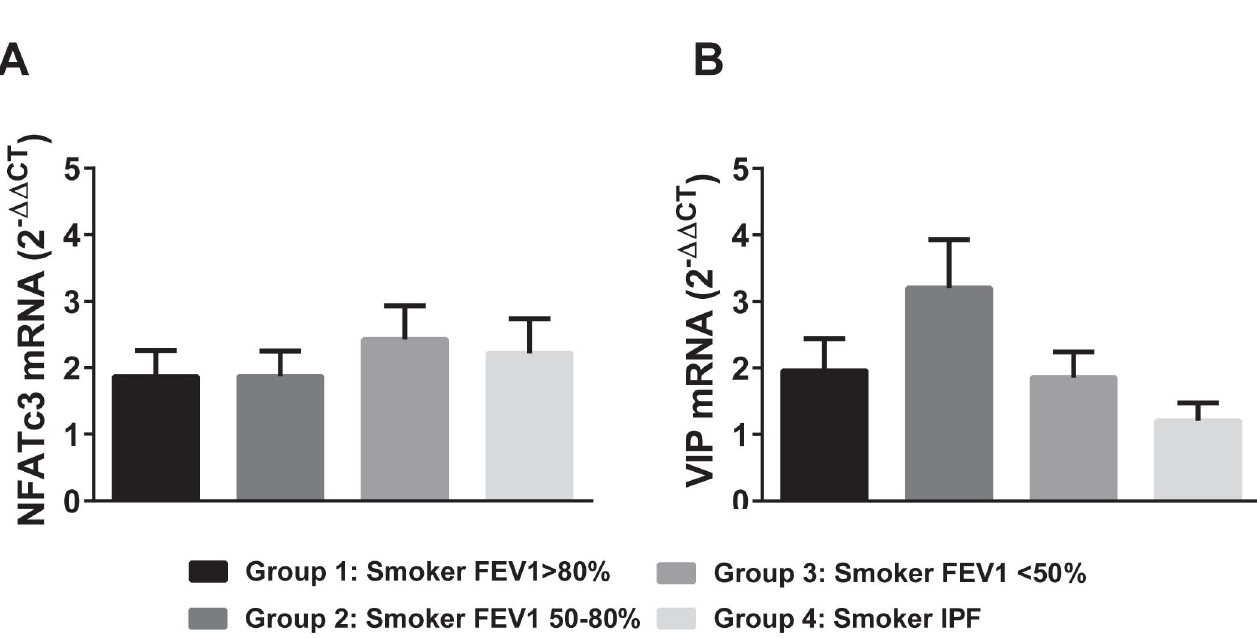
Fig 6. NFATc3 and VIP mRNA levels in lungs from COPD and IPF patients. NFATc3 and VIP mRNA levels were determined by real time PCR in lungs from patients from groups 1–4.